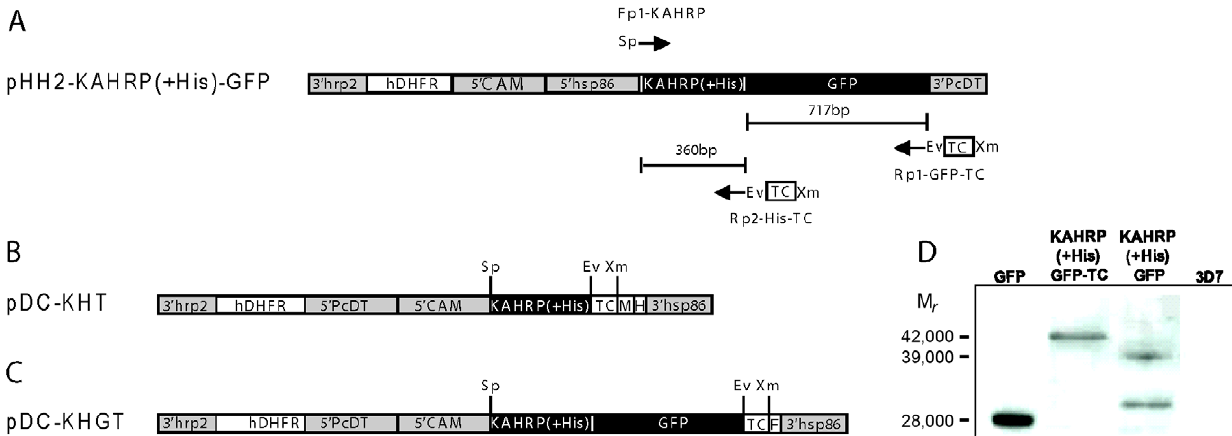
Figure 1. Transfection plasmids and detection of GFP fusion proteins. (A) Plasmid pHH2-KAHRP( + His)-GFP [14] was used to amplify the first 60 amino acids of KAHRP containing the putative hydrophobic signal sequence followed by the histidine rich region with or without GFP fusion. 3 9 hrp2 , histidine-rich protein-2 3 9 UTR; hDHFR , human dihydrofolate reductase gene; 5 9 CAM , Pf calmodulin promoter region; 5 9 hsp86 , heat-shock protein-86 promoter region; 3 9 PcDT , P. chabaudi dihydrofolate reductase 3 9 UTR; Fp1-KAHRP, forward primer used to add a Spe I restriction site (Sp) immediately before the first codon of KAHRP cloned into pDC-pvcrt-o-MH (not shown); Rp1-GFP-TC, reverse primer used to amplify GFP, add an Eco RV restriction site (Ev) in frame between GFP and the TC tag (for subcloning of other genes), and add a Xma I restriction site (Xm) after the TC sequence, for cloning into pDC-pvcrt-o-MH; Rp2-His-TC, reverse primer used to amplify the histidine rich region of KAHRP, add an Eco RV restriction site (Ev) while maintaining the reading frame of KAHRP( + His) and the TC tag (for future subcloning of other genes), and add a Xma I restriction site (Xm) after the TC sequence, for cloning into pDC-pvcrt-o-MH. (B) Transfection plasmid pDC-KHT contains the sequence for the fusion protein KAHRP( + His)-TC from pHH2-KARHP( + His)-TC. Myc (M) and His 6 6 (H) tags are encoded immediately after the Xma I restriction site. (C) Transfection plasmid pDC-KHGT contains the sequence of KAHRP( + His)-GFP-TC in frame with codons for a PRGTKTYF terminus (F) that begin at the Xma I site. 5 9 PcDT , P. chabaudi dihydrofolate reductase promoter region; 3 9 hsp86 , heat-shock protein-86 3 9 UTR. (D) Immunoblot image shows antibody detection of GFP as a M r 28,000 band, detection of KAHRP( + His)-GFP-TC as a M r 42,000 band, and detection of M r 39,000 and M r 29,000 bands from KAHRP( + His)-GFP protein. No band was detected from control non-transformed 3D7